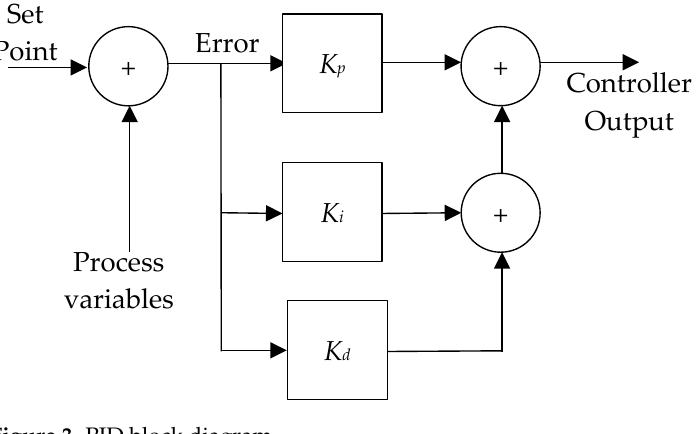
Figure 3. PID block diagram.